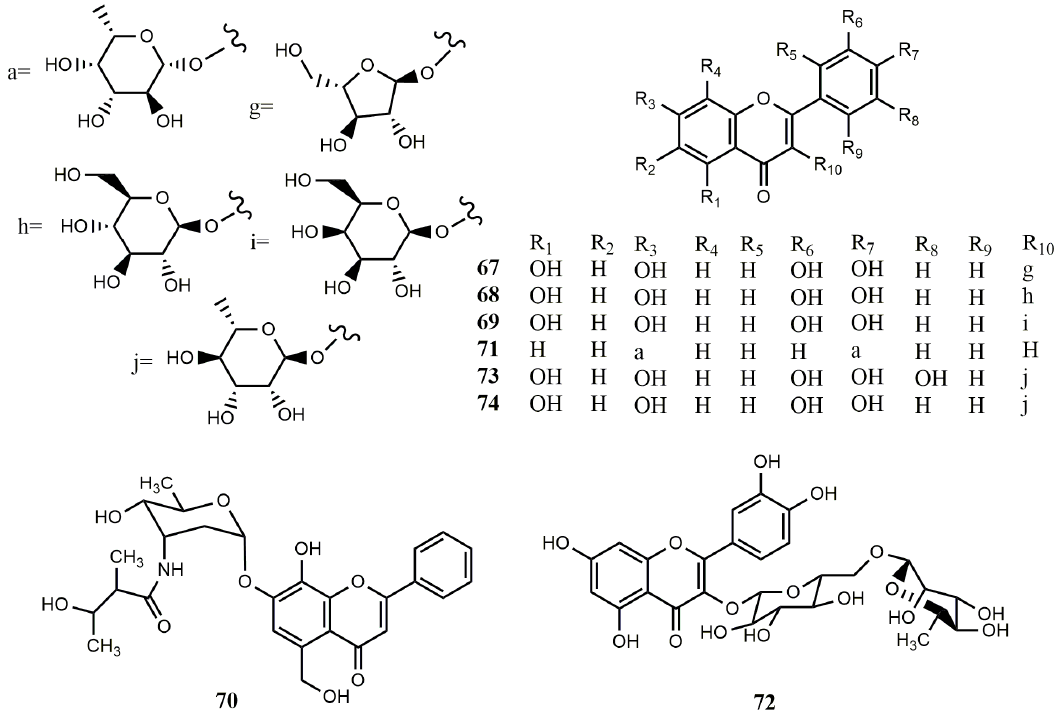
Figure 4. Reported structures of simple flavonoids 50 – 66 from fungi and actinomycetes. Molecules 2020 , 25 , x FOR PEER REVIEW